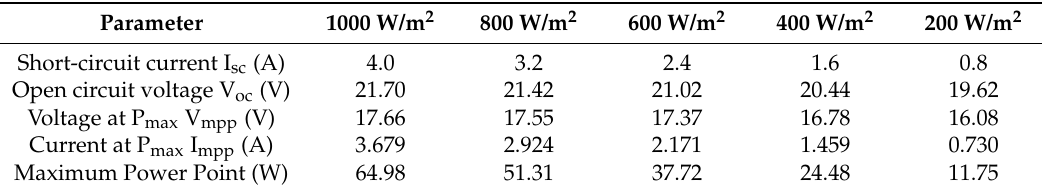
Table 2. Parameters of the PV module for variable solar irradiance.